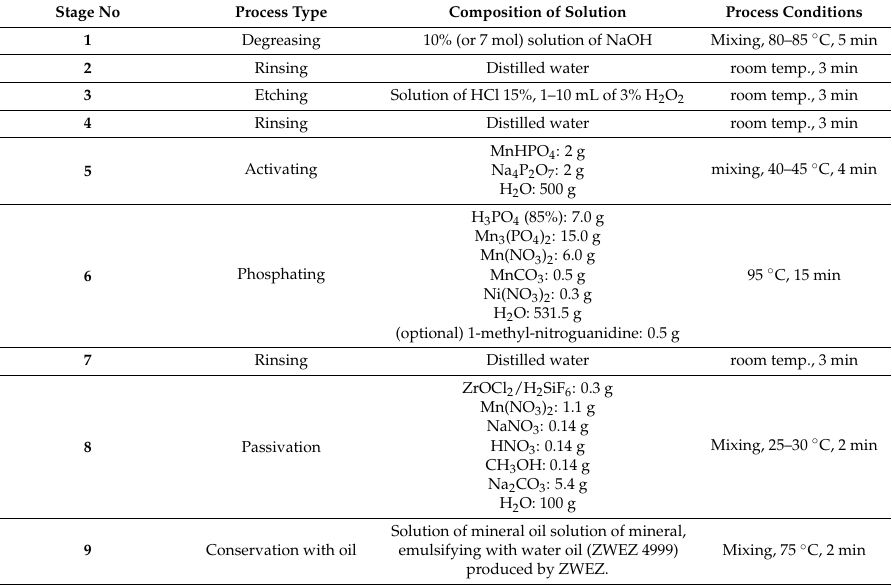
Table 2. The chemical composition of manganese phosphating treatment and process